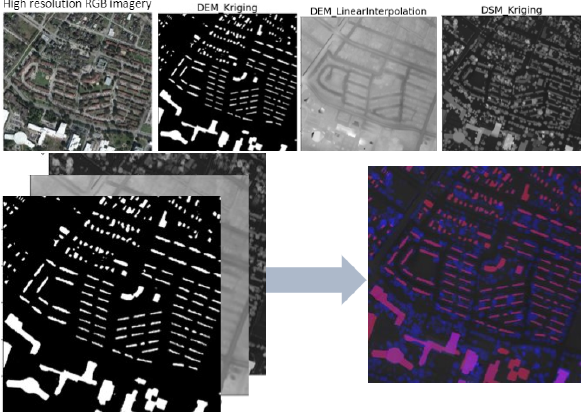
Figure 4. DEM dataset created from DEM kriging, DEM triangulation, and DSM.